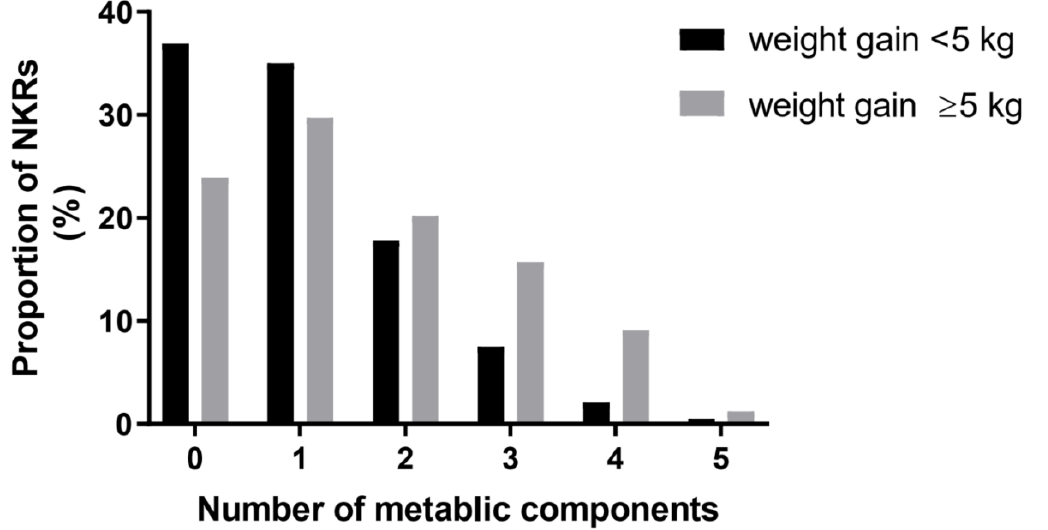
Figure 1. Number of metabolic syndrome components according to degree of weight gain.